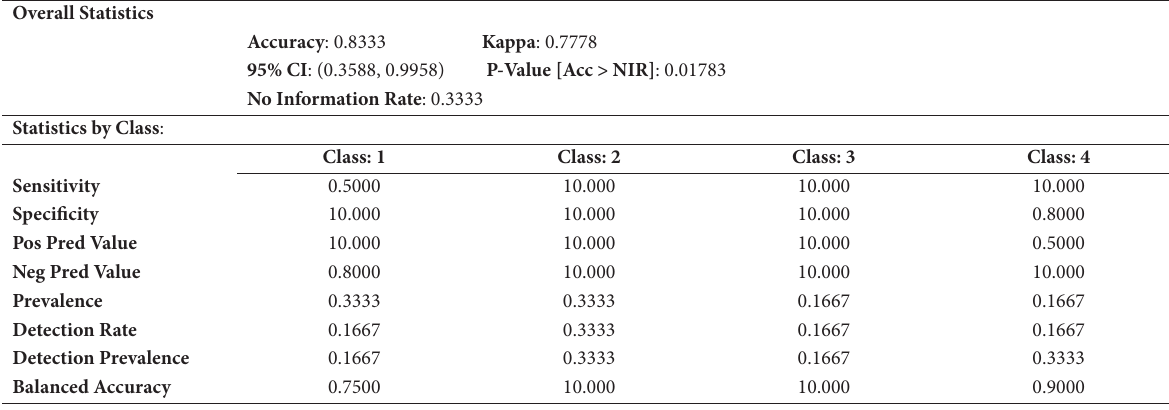
Table A2. Accuracy statistics. Classification accuracy (%) for the index classification when applied to the validation dataset. Train- ing data consisted of a random sample (80%) of the full dataset and validation was conducted on the remaining data. Overall